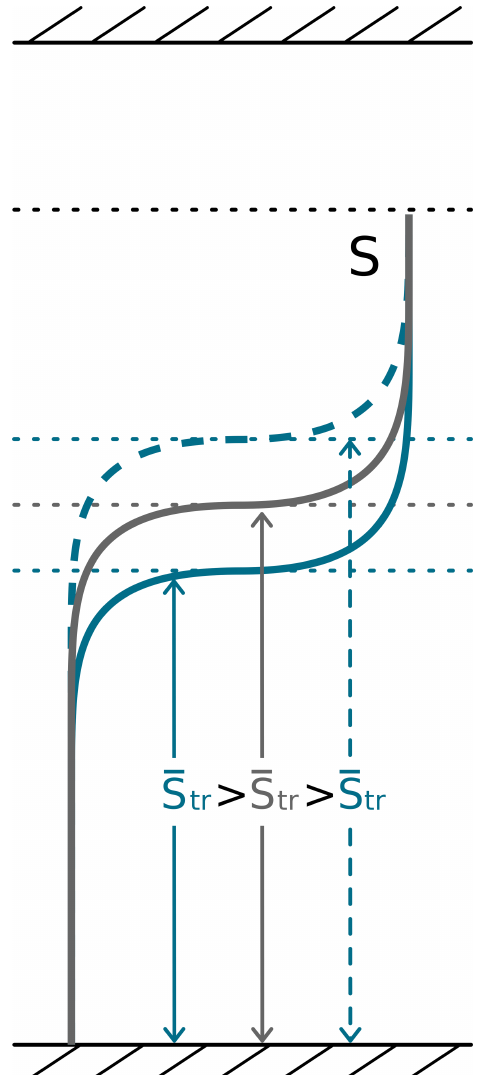
Figure 7. Schematic illustrating how the altitude of the tropopause modifies the vertical average of the tropospheric stratification S